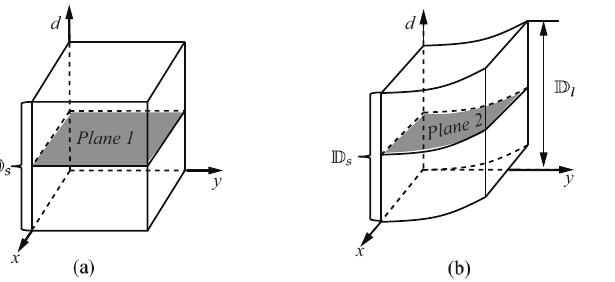
Figure 8. Illustration of cost volume: ( a ) common cost volume and ( b ) the leaning cost volume proposed in this paper for long distance